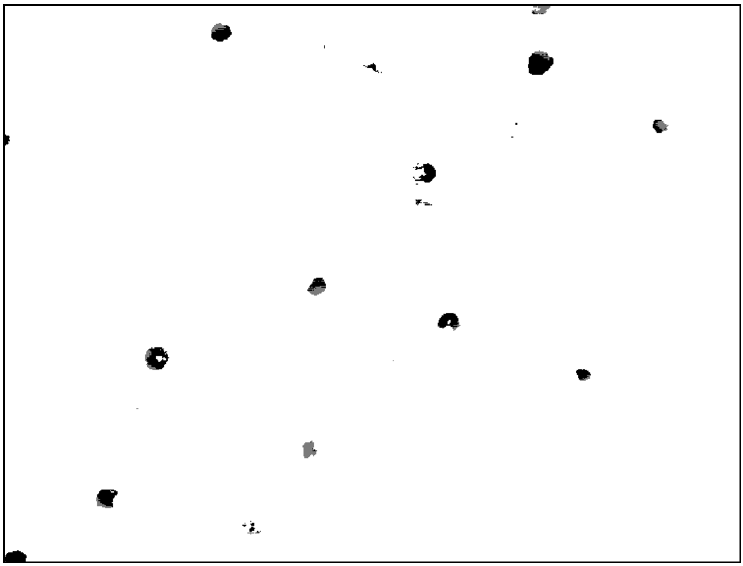
Fig. 5. Result of training of control nuclei. The nuclei are segmented into two classes (here marked by grey and black), and the parameters needed to reproduce the transformation and segmentation are stored in a classifier